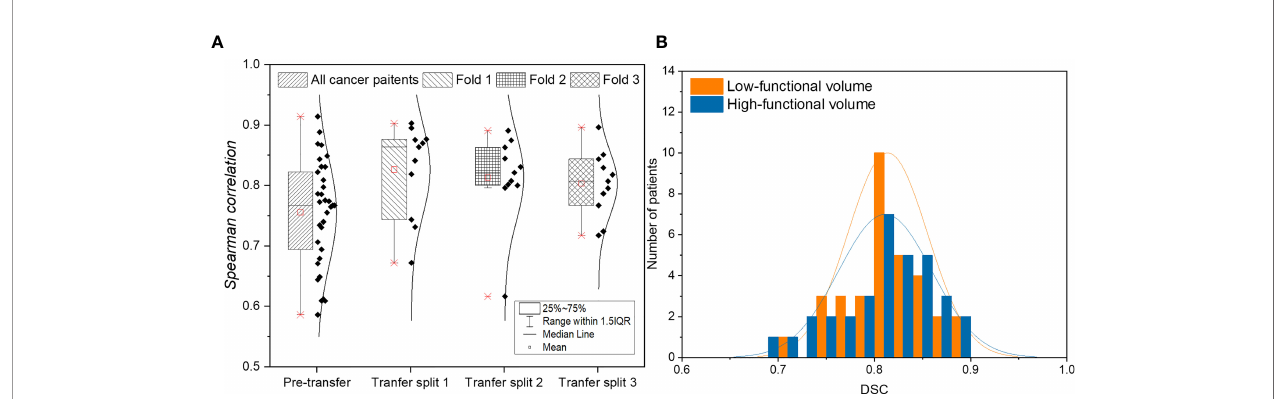
FIGURE 2 | (A) Evaluation of voxel-wise correlation of lung cancer patients before and after applying transfer learning. (B) Histogram of function-wise similarity evaluation in terms of DSC for low/high functional volumes. (A) shows the result of voxel-wise correlation evaluation before and after transfer learning using the CTPM method. The CT-based perfusion images in the three splits after transfer learning achieved a high correlation value (R) of 0.8263 ± 0.0767, 0.8133 ± 0.0727, and 0.8032 ± 0.0537, respectively, with an average correlation value of 0.8142 ± 0.0669 for all three splits. Compared with the testing results before transfer learning (0.7554 ± 0.0875), there was a signi fi cant improvement of the average of all splits (7.78%, p = 0.0047) in the performance after fi ne-tuning of the model. (B) shows the function-wise similarity evaluation of low-functional volume (LFV) and high-functional volume (HFV) in RT treatment planning between SPECT perfusion images and CT-based perfusion images. The mean DSC for LFV and HFV were 0.8137 ± 0.0414 and 0.8112 ± 0.0484, respectively, suggesting a high similarity of both levels of functional volumes. Among the 33 lung cancer patients, a high DSC value of greater than 0.8 was achieved in 67% of patients for high-functional volume and 70% for low-functional volume; almost all the lung cancer patients (33 for low-functional volume, and 32 for high- functional volume) demonstrated a DSC value larger than